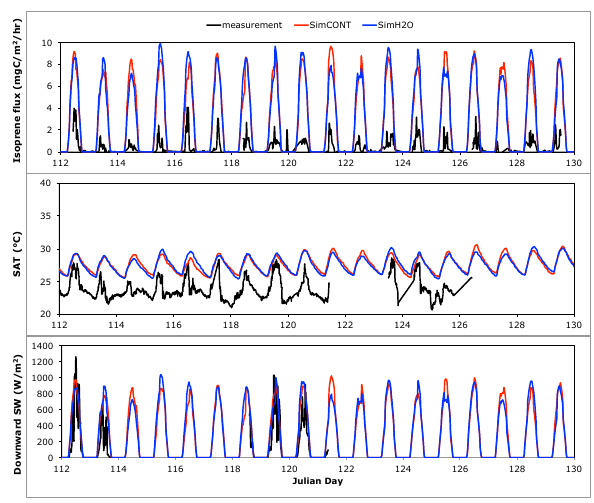
Figure 7e. Results for wet season Borneo during April 21 - May 9 2008. Fig. 7e. (a–f) Time evolution of isoprene emission flux, surface air temperature (SAT) and downward shortwave (SW) radiation at the tropical measurement sites. Measurements are shown in black (where data is available). Model climatological results are averages of 10 simulation years in SimCONT (red) and SimH2O (blue). (e)